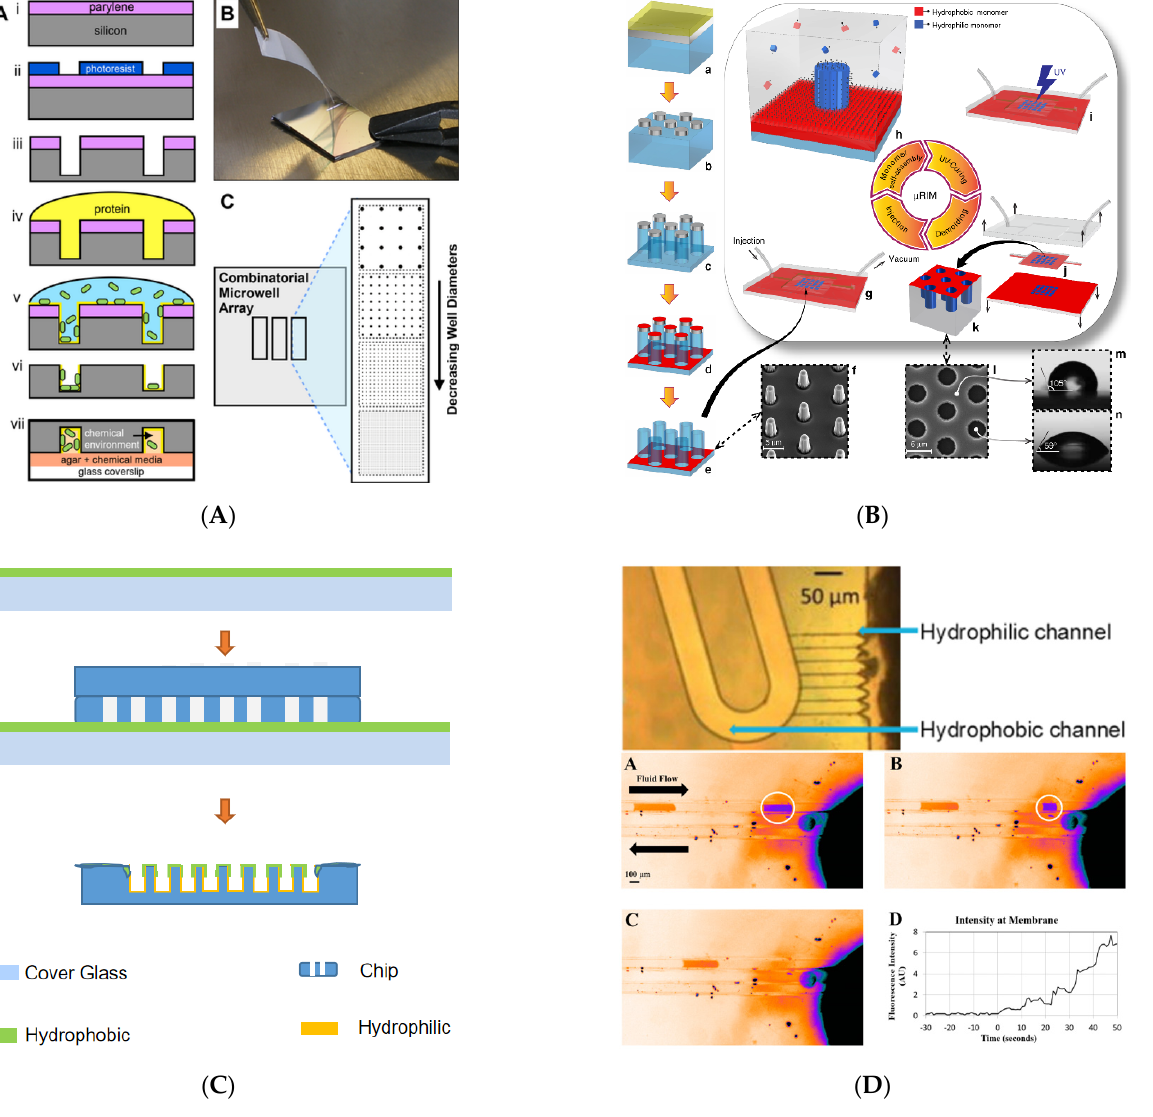
Figure 2. Some examples of surface treatment. ( A ) Microwell arrays for bacteria stochastic assembly. Reprinted with permission from [97]. ( B ) Hydrophilic in-hydrophobic femtolitre-well arrays. Blue color indicates hydrophilic surfaces; red color hydrophobic surfaces. Reprinted with permission from [98]. ( C ) Spin coating liquid hydrophobic liquid to make surface and part of chip wall hydrophobic. ( D ) Local hydrophilic/hydrophobic treatment silicon chip used in sampling (the top half part) and hydrophilic membrane used in microfluidic droplet extraction (the lower half part). Reprinted with permission from [80,99].